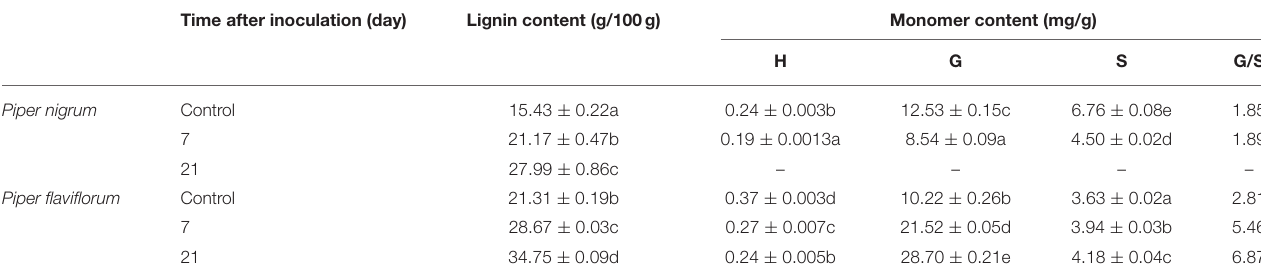
TABLE 1 | Stem lignin content and monomer composition in the two species of Piper after inoculation with P. capsici . Time after inoculation (day) Lignin content